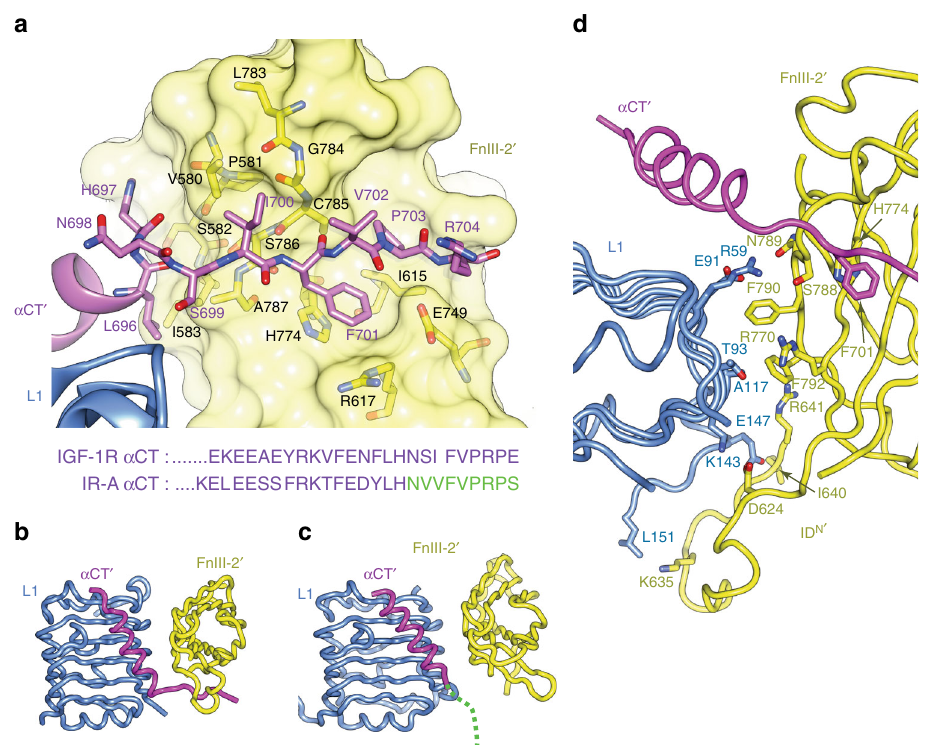
Fig. 4 Con fi guration of α CT ΄ and domains L1 and FnIII-2 ΄ of apo IGF-1R Δβ . a Ordering of the C-terminal region of the apo IGF-1R Δβ α CT ΄ segment upon the surface of the adjacent domain FnIII-2 ΄ . Inset below is a sequence alignment of residues at the C terminus of the respective α chains of IGF-1R Δβ and IR Δβ ; residues in green are disordered in the crystal structure of the IR Δβ 8 . Note that the α CT segment of IR Δβ is that of the A isoform of the receptor 7 . b Association of the α CT ΄ segment with domains L1 and FnIII-2 ΄ within the crystal structure of apo IGF-1R Δβ . c Association of the α CT ΄ segment with domain L1 alone within the crystal structure of apo IR Δβ . Green dashed line represents the disordered C-terminal region of the α΄ chain of IR Δβ . The view direction in b and c is equivalent with respect to the domain L1. d Interaction between domains L1 and FnIII-2 ΄ within apo IGF-1R